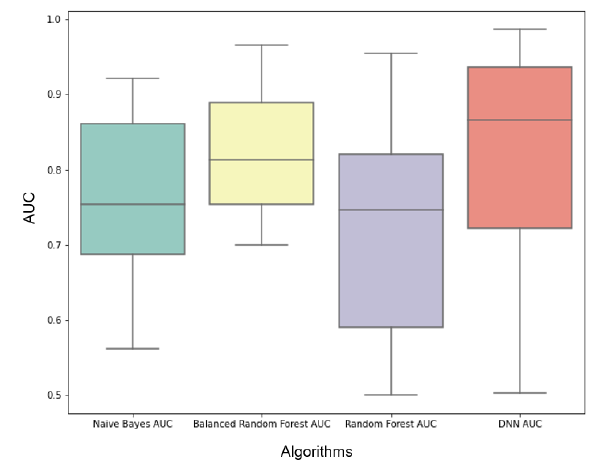
Figure 4. The box plots comparing the AUC among the four trained algorithms to generate